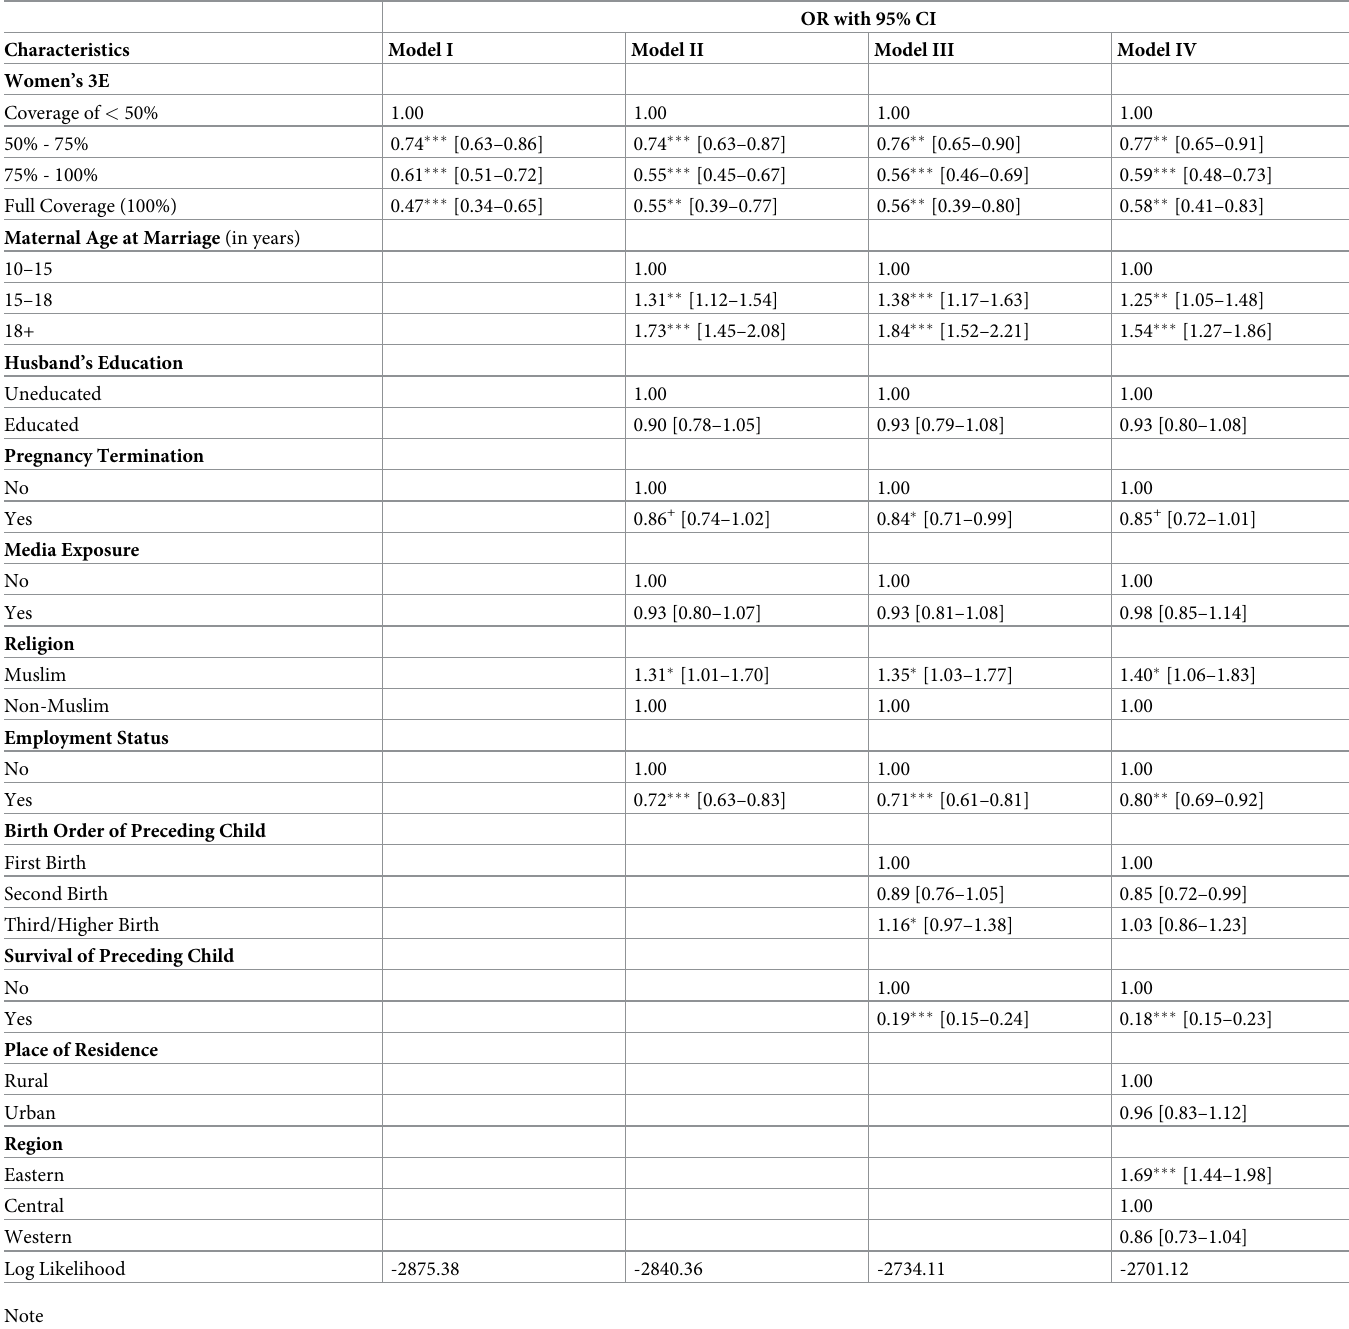
Table 4. Odds ratio (OR) with 95% confidence intervals (CI) obtained from sequential binary logistic regression